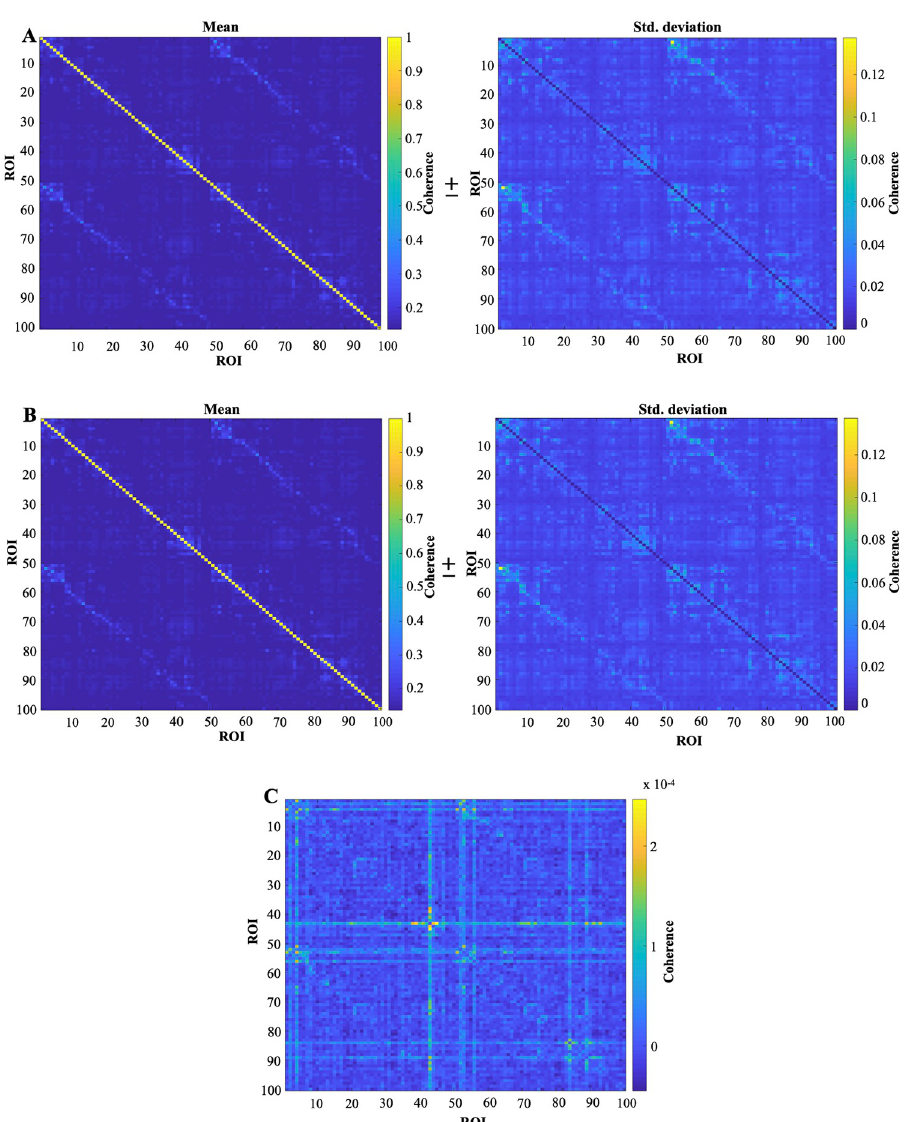
Fig 8. Whole brain FC matrix (comprising of 100 ROI) based on the coherence. The coherence FC matrix of each subject in each run is averaged across to find one representative FC matrix (mean ± std. deviation). (A) Coherence FC matrix (mean ± std. deviation) (for 100 ROI) obtained from the resting-state BOLD time series. (B) Coherence FC matrix (mean ± std. deviation) (for 100 ROI) obtained from the ARFIMA (1, d , 0) BOLD time series. (C) The difference between the mean coherence FC matrix of the resting-state BOLD dataset (A) and the filtered BOLD time series of the whole brain (B).